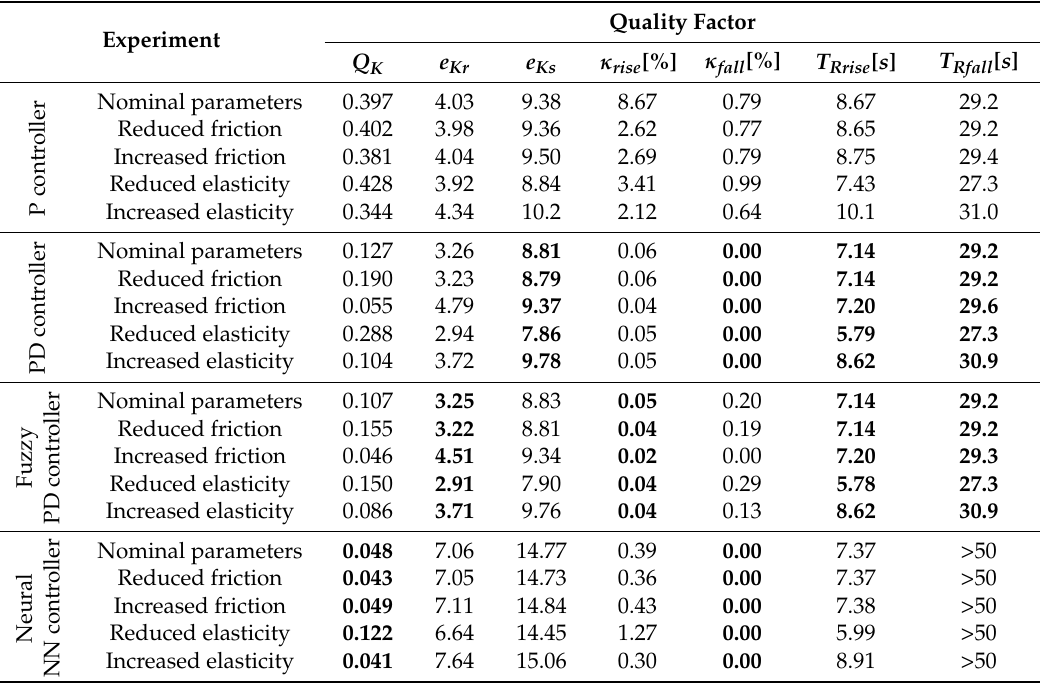
Table 3. Experimentally obtained values of control quality factors.